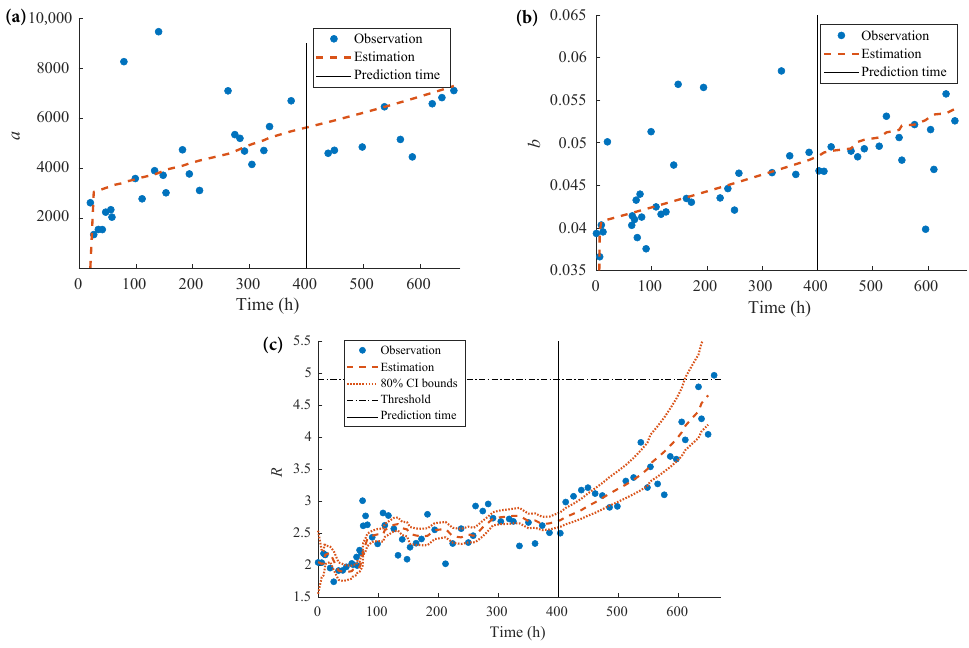
Figure 6. Internal Parameters Prediction at t λ = 400 h: ( a ) Prediction of parameter a ; ( b ) Prediction of parameter b ; ( c ) Prediction of parameter R